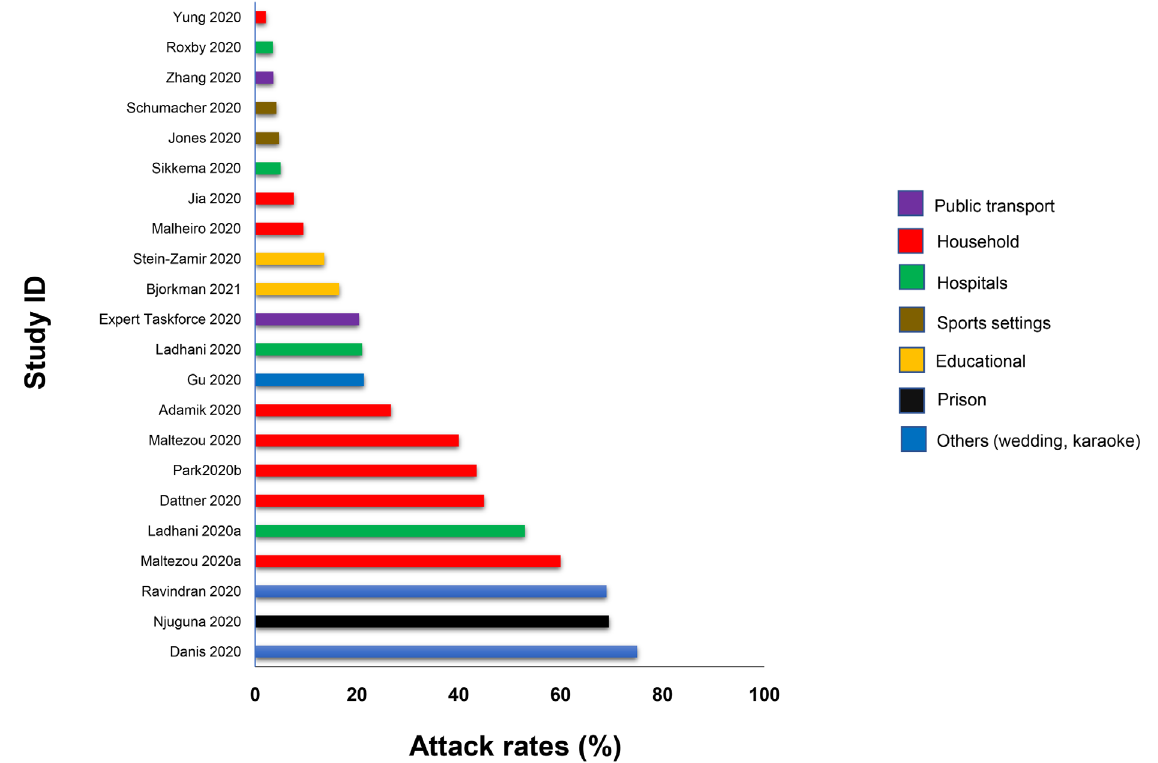
Figure 3a. Primary attack rates of SARS-CoV-2 in close contacts (PCR).